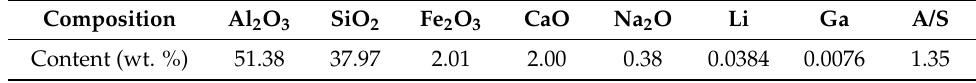
Table 1. Chemical composition of